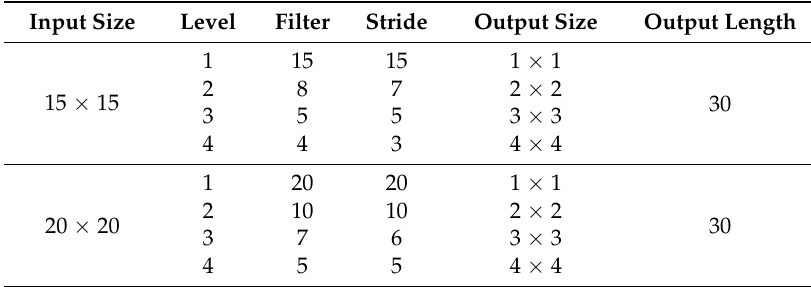
Table 1. Parameters of a 4-level SPP.